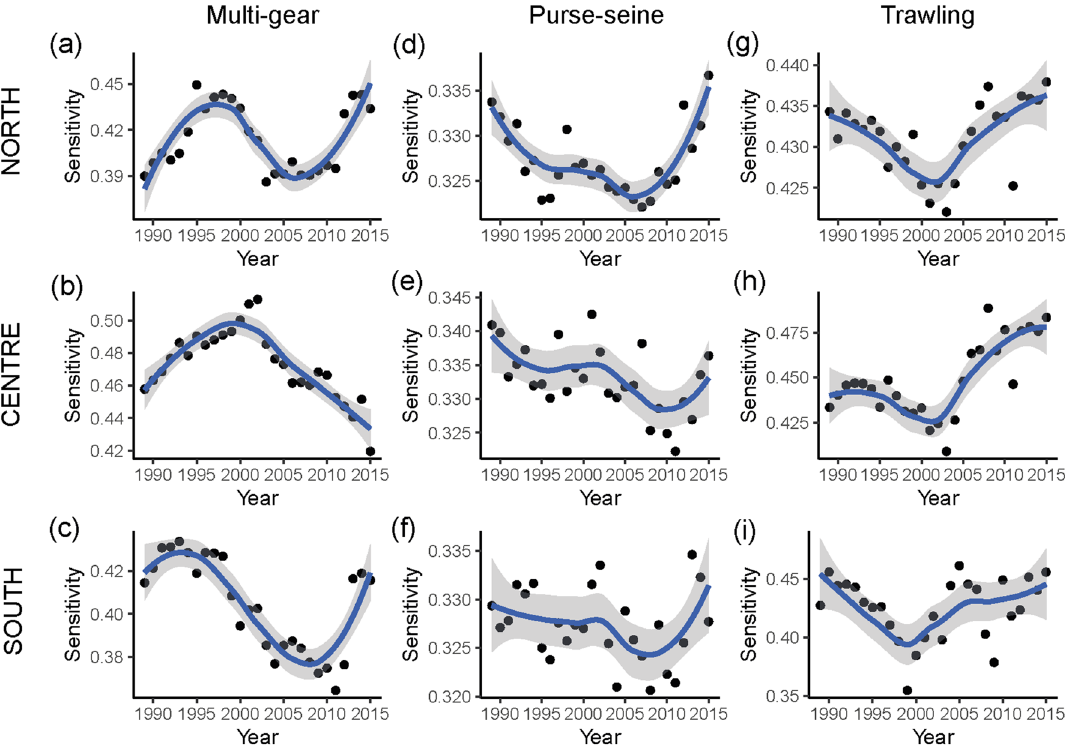
Figure 2. Ecological Sensitivity of the Landing (ESL) time series (dots) and temporal trends from 1989 to 2015 of each fishing fleet and area; Multi-gear ( a -North; b -Centre; c -South), purse-seiners ( d -North; e -Centre; f -South), and trawlers ( g -North; h -Centre; i -South). A local polynomial regression (LOESS) fit is shown in blue, with 95% confidence intervals as a grey